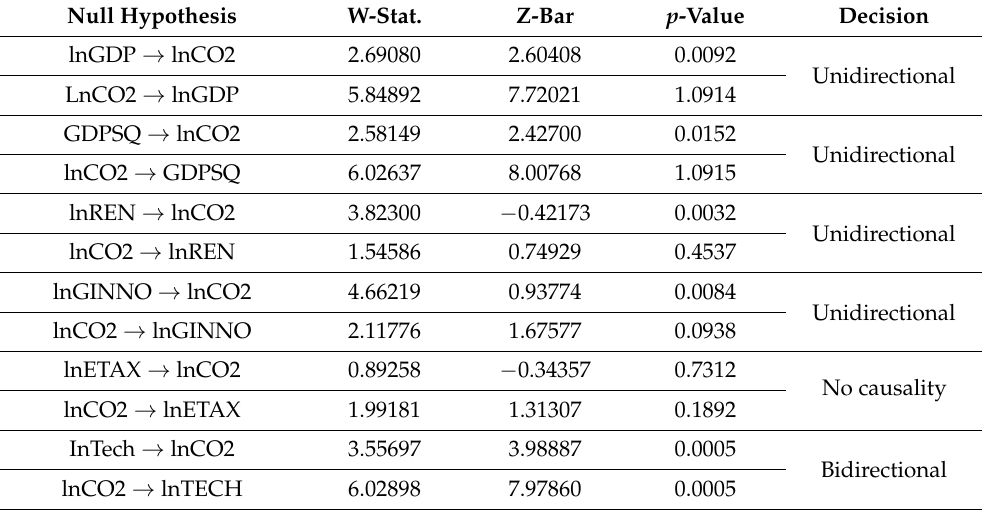
Table 8. D.H. Causality